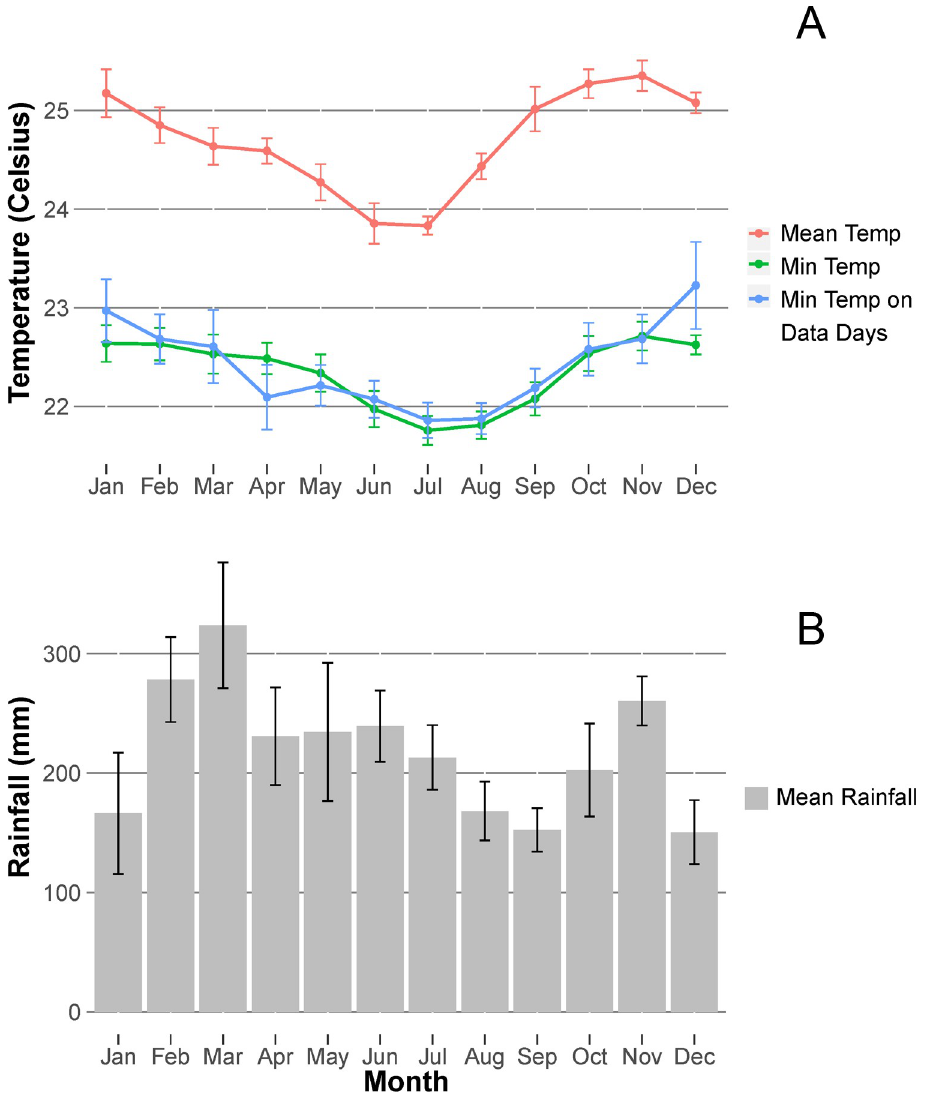
Fig 2. Weather patterns at the Tiputini Biodiversity Station. A . Monthly variation in mean daily temperatures, mean daily minimum temperatures, and mean daily minimum temperatures for the subset of days when behavioral data were collected. Temperature was recorded for 77% of 4364 days between June 2005 and June 2017. B. Mean monthly rainfall recorded for 86% of 2871 days between June 2008 and April 2016. Months with data for fewer than 15 days were excluded from the averages. Error bars indicate standard